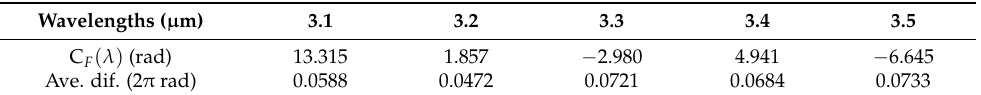
Table 4. Phase corrections and average differences of the focusing metalens at wavelengths from 3.1 to 3.5 µ m.